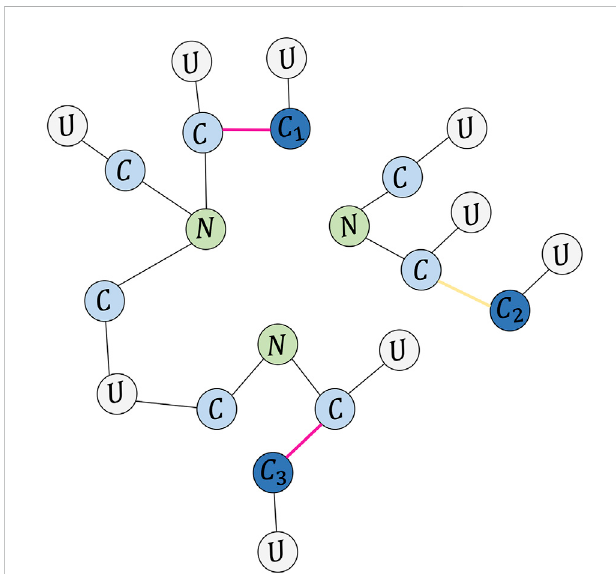
FIGURE 3 Example of a comment tree. C represents a comment, N means news, and U denotes a user. The red line from comment ’ s node to comment ’ s node means controversy, while the yellow line means non- controversy, and the node in deep blue C 1 , C 2 , C 3 are leaf